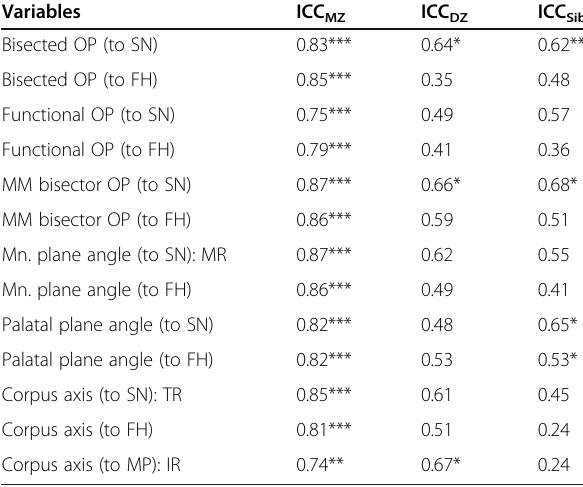
Table 3 Intraclass correlation coefficient (ICC) in MZ, DZ, and sibling